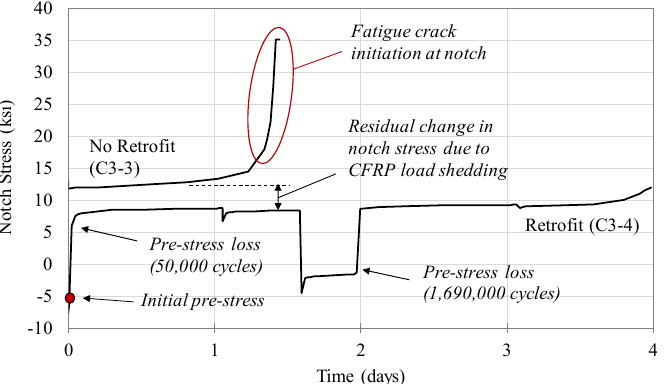
Figure 35. Measured stress at the notch of specimen C3-3 (no retrofit) and specimen C3-4 (retrofit).